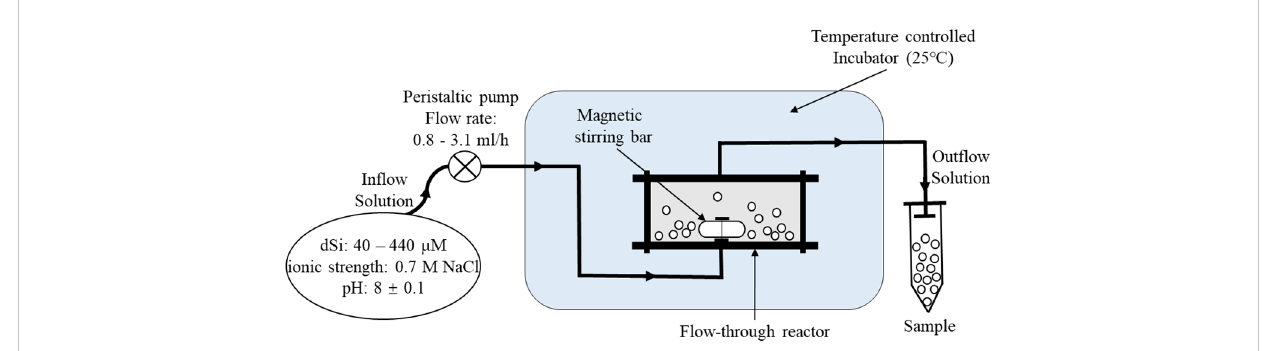
FIGURE 2 Schematic illustration of continuous fl ow-through experiments. In fl ow solution with different dSi concentrations and given conditions were added to the reactor by a fl ow rate controlled peristaltic pump. PTFE pipes were used for interconnecting all parts of the system.